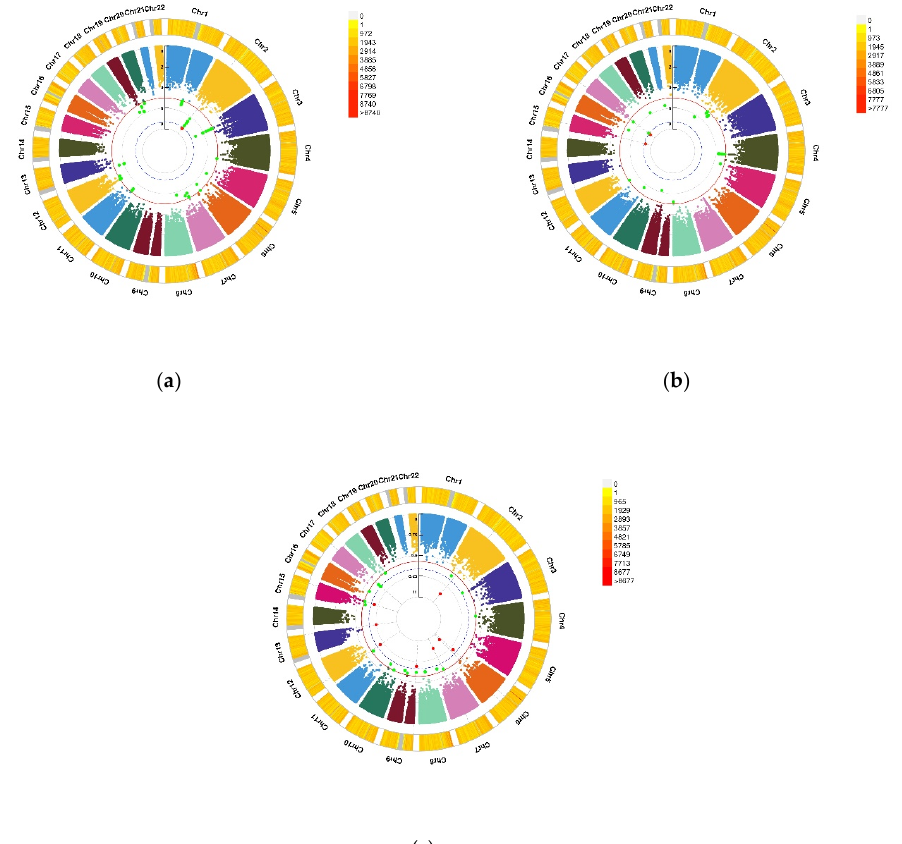
Figure 2. Genomic regions interacting with VD PRS after COJO adjustment for depression status, anxiety status, and GAD score. ( a ) Depression status, a SNP allele was found to significantly interact with blood VD in depression status; ( b ) Anxiety status, 2 independent SNP alleles were found to significantly interact with blood VD in anxiety status; ( c ) Anxiety (GAD score), 8 independent SNP alleles interacted significantly with blood VD in anxiety disorders (GAD score). From the center, the first circos depicts the −log10 p -values of each variant due to double exposure, i.e., the effect of both SNP allele and VD PRS after COJO adjustment. The second circos shows chromosome density. Red dots represent the p < 5 × 10 −8 and green dots represent p < 1 × 10 −7 . The figure was generated using the “CMplot” R script (https://github.com/YinLiLin/R-CMplot) (accessed on 15 February 2021).